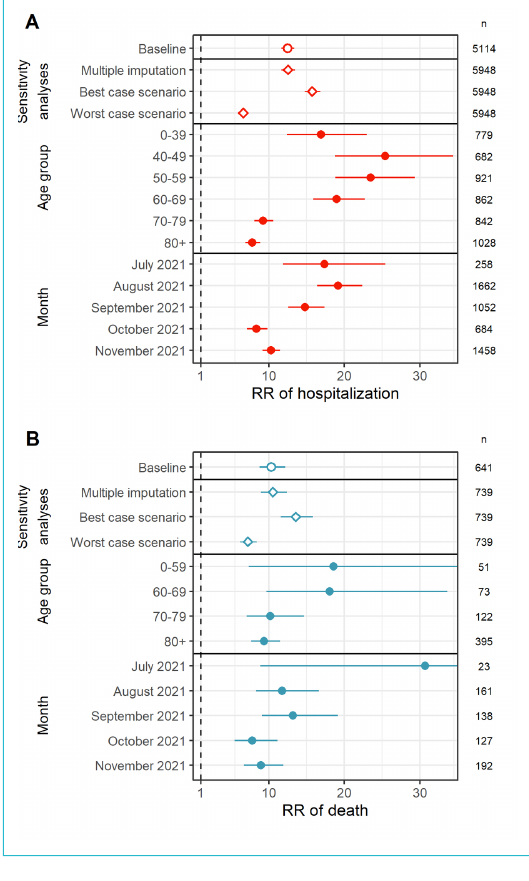
Figure 2: (A) Relative risk (RR) of COVID-19-related hospitalisa- tion for individuals without full vaccination compared to individuals with full vaccination in the baseline analysis, in three sensitivity analyses, by age group, and by month. (B) Relative risk of death for individuals without full vaccination compared to individuals with full vaccination in the baseline analysis, in three sensitivity analy- ses, by age group, and by month. Numbers correspond to group sizes